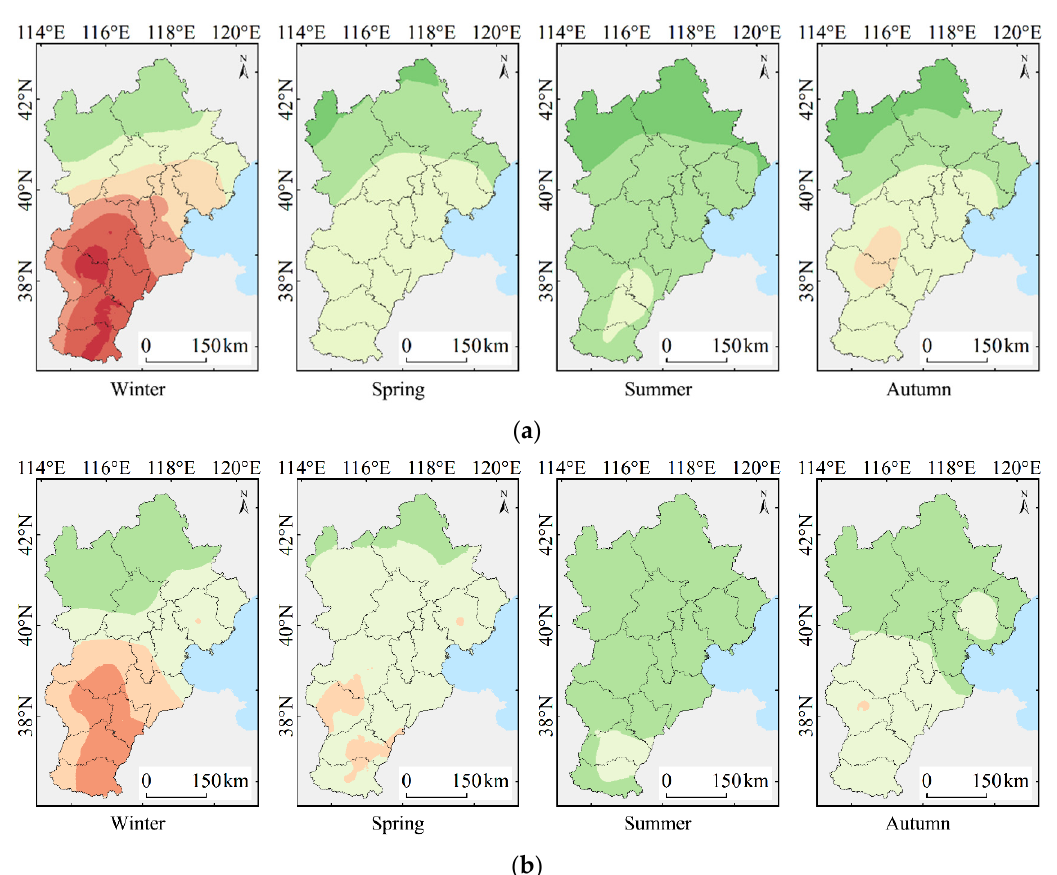
Figure 6. Spatial distribution of the seasonal mean values of PM 2.5 ( a ) and PM 10 ( b ) concentrations. The average seasonal PM 10 concentration was also highest in winter, and the ranges of areas with Level 5 and 6 concentrations, accounting for 21.0% and 17.4%, respectively, of the regional area, were concentrated in the southern region, which was mildly polluted. Areas with Level 3 and 4 concentrations occupied most of the north, accounting for 32.1% and 29.4%, respectively, of the regional area. In the spring, the relatively high ‐ value area in the south contracted, and the change in the PM 10 concentration distribution in the north exhibited a different trend from that of the PM 2.5 concentration distribution. The concentration increased slightly, but the relatively low ‐ value area contracted northwards, which was related to the frequent dusty weather conditions in spring. Level 5 concentrations were observed in southern cities, accounting for 7.8% of the total area. The range of areas with Level 4 concentrations was reduced to 10.8%, while the rest of the area exhibited Level 3 concentrations, accounting for 81.4% of the regional area. In summer, the concentration was the lowest and the concentration in the whole region remained below Level 4. Except for areas with Level 4 concentrations, which accounted for 6.4% of southern cities such as Xingtai and Handan, the remaining area (93.6%) exhibited Level 3 conditions. In autumn, the concentration rose slightly. Except for the Level 5 concentrations in Shijia ‐ zhuang, which accounted for 0.3% of the area, all other areas failed to meet the pollution standard, with the ranges of areas with Level 3 and 4 concentrations accounting for 55.4% and 44.4%, respectively, of the total area. Figure 7 shows the spatial distribution of the seasonal mean value of the PM 2.5 /PM 10 ratio. The PM 2.5 /PM 10 ratio varied greatly between different seasons. In winter, the ratio was the highest, with a Level 9 value observed at the centre of Beijing, Level 8 values occurring in the surrounding areas and Level 7 values distributed in the other areas. PM 2.5